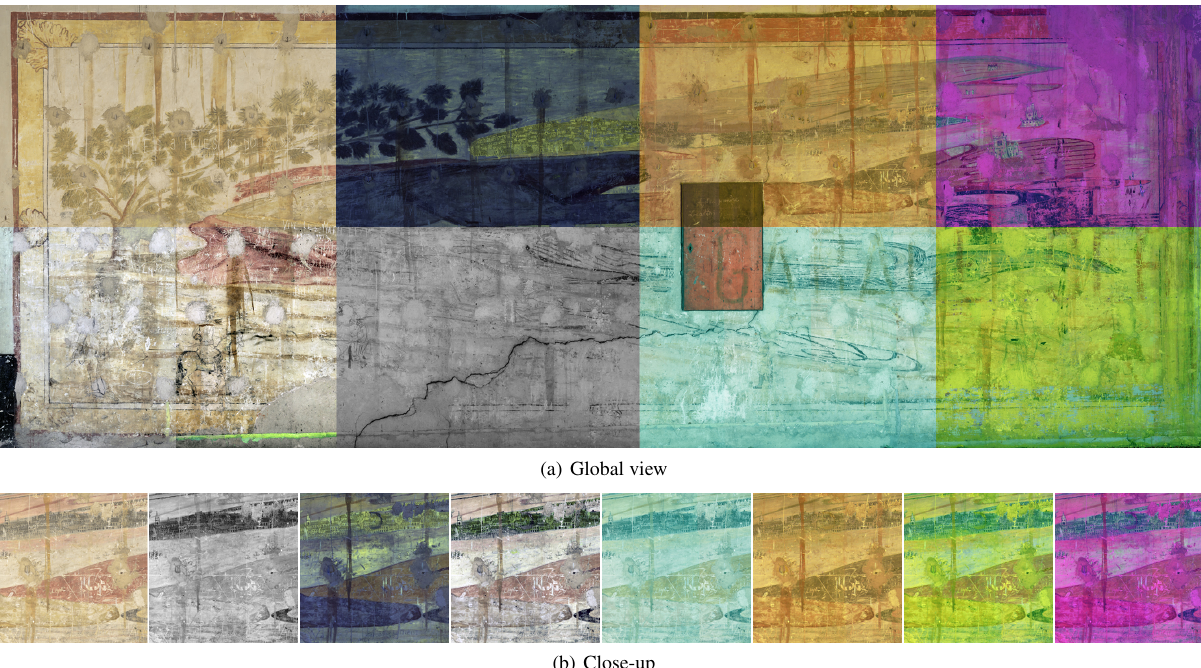
Figure 13: Multilayered orthophoto generated on Anamorphosis case-study : (a) Mosaic view of TP techniques implemented and some colorimetric computational possibilities; (b) Samples extracted from the same area (from the left to the right), VIS, IR, UVf, Median composite, IRfc, UVf composite and synthetic VIS/IR/UV